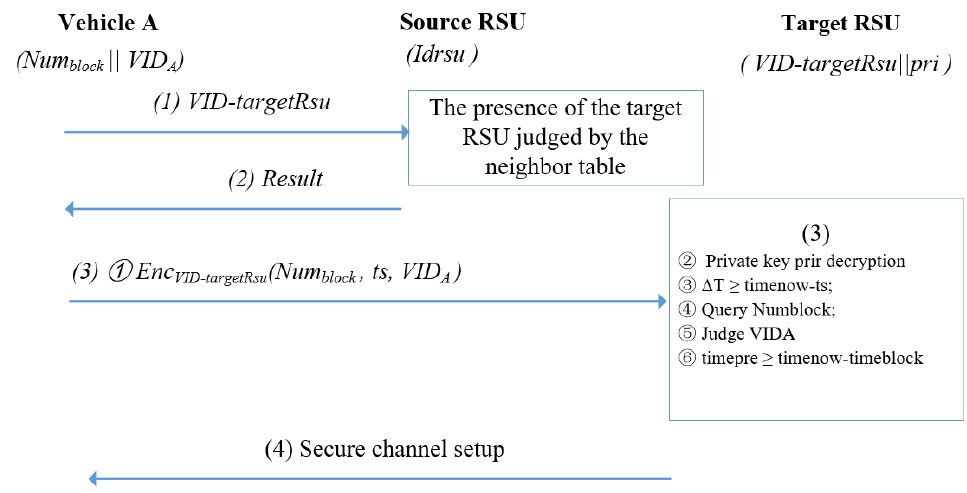
Figure 5. Handover authentication process.